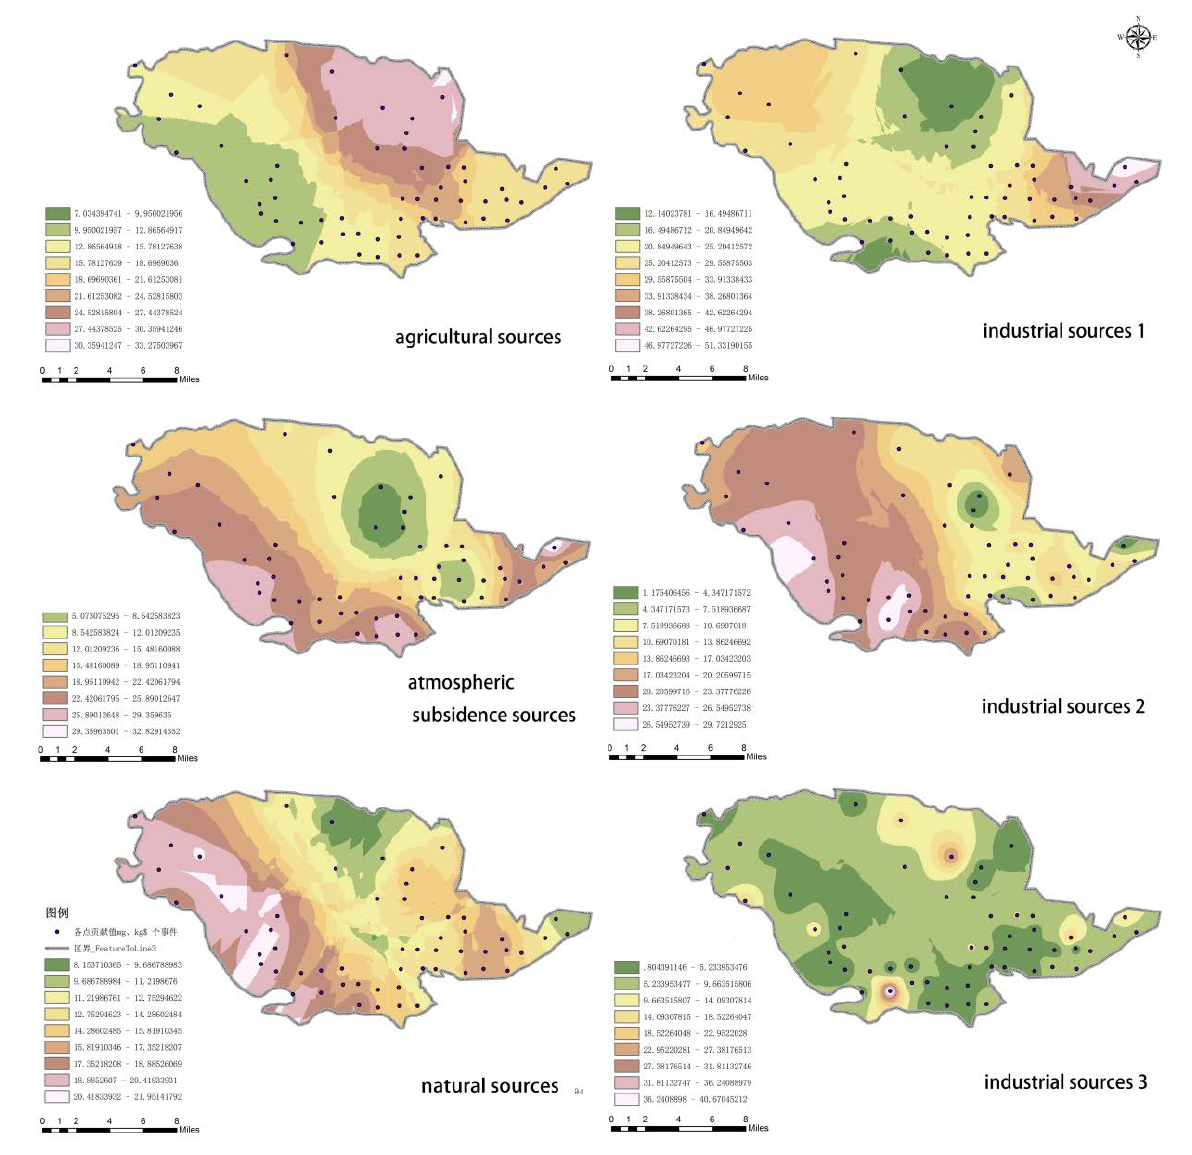
Figure 9: Spatial distribution characteristics of various pollution